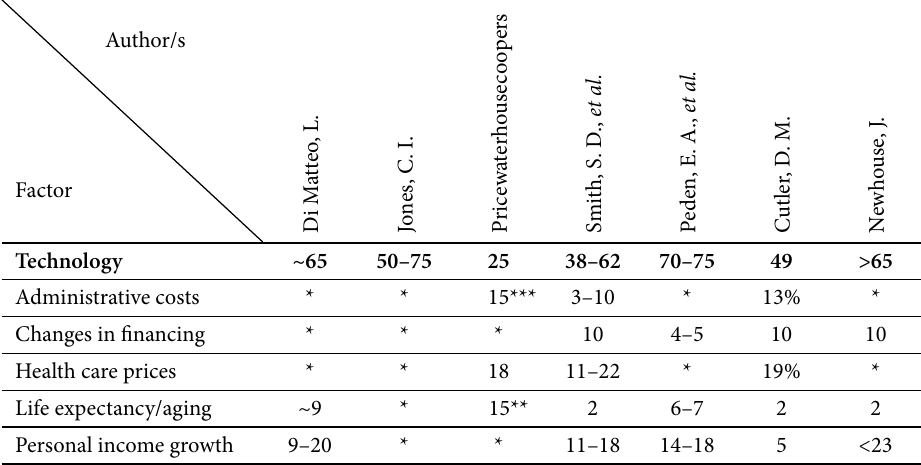
Table 1. Contributions of selected factors to growth in health care spending in